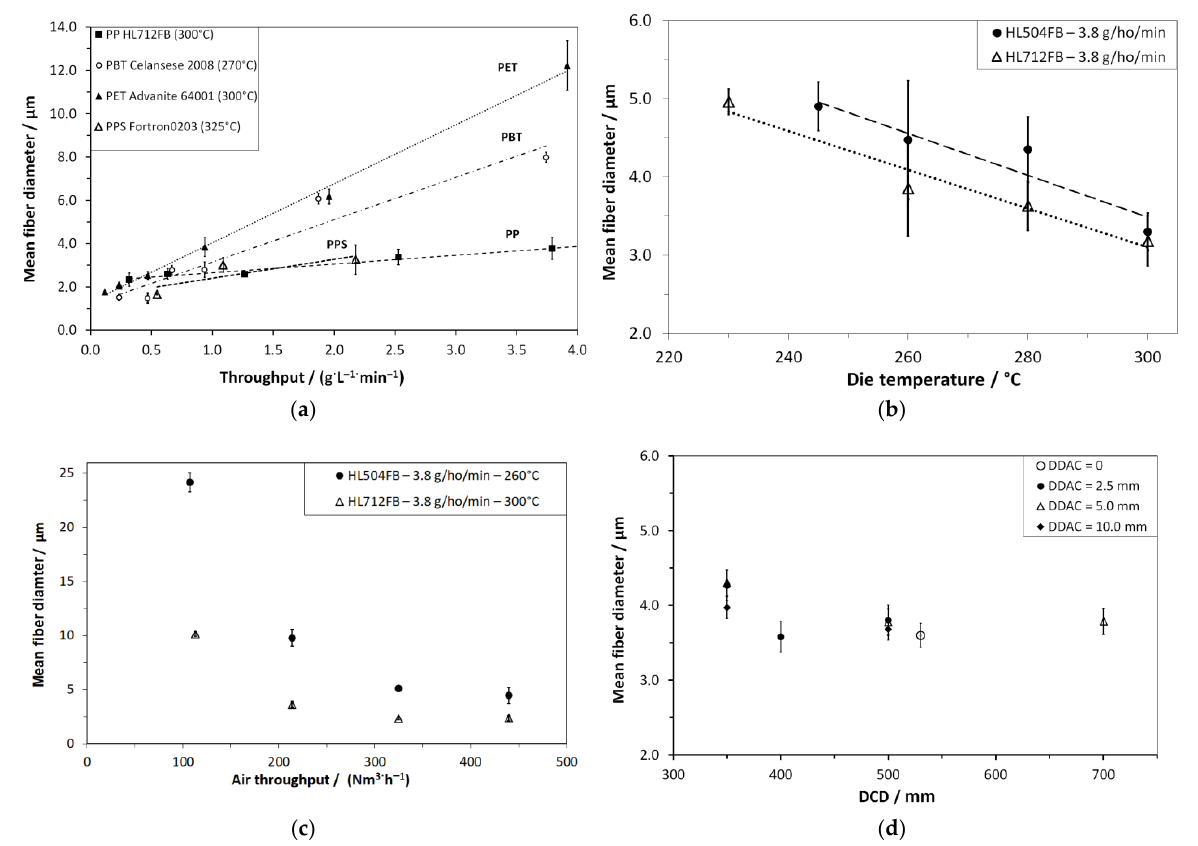
Figure 5. Mean fiber diameters as a function of different process parameters: ( a ) vs. polymer throughput (PP HL712FB, PBT Celanese 2008, PET Advanite 64001, and PPS Fortron 0203; 𝑉̇ air = 220 Nm 3. h −1 ); ( b ) vs. air throughput (PP HL504FB and HL712FB, 𝑉̇ = 3.8 g . ho −1. min −1 ); ( c ) vs. die temperature (PP HL712FB and PP HL504FB), V ̇ = 3.8 g.ho −1 .min −1 , V ̇ _air= 220 Nm3.h −1 ) ( d ) vs. DCD and distance die-air channel (PP HL712FB , T melt = 300 °C, 𝑉̇ = 3.8 g . ho −1 .min −1 , 𝑉̇ air = 220 Nm 3. h −1 ); the lines represent linear fits .